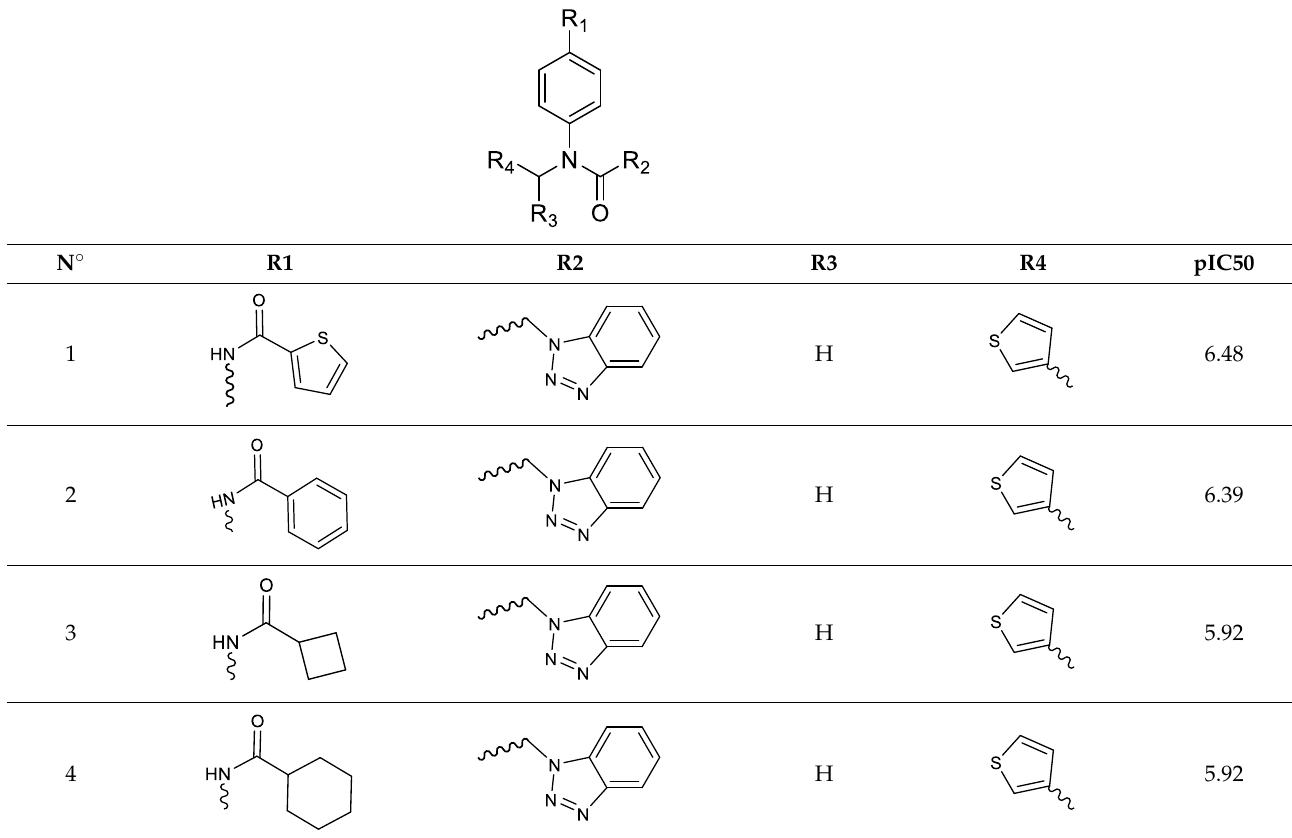
Table 1. Chemical structures and activity experiment of 41 peptidomimetic compounds.